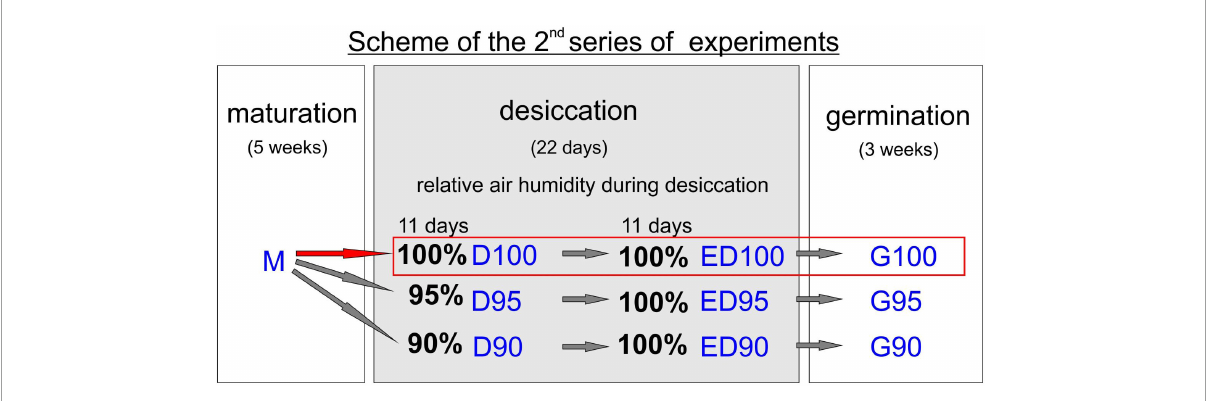
FIGURE1 Design of the second series of experiments and sampling. Mature somatic embryos (5 weeks of maturation, M) were subjected to three different systems of desiccation. Control embryos (in red) were exposed to 100% relative humidity throughout the process (sampling D100 and ED100). The second and third groups of embryos were subjected to 95 and 90% relative humidity, respectively, during the first half of desiccation (sampling D95 and D90) and then transferred to 100% relative humidity (sampling ED95 and ED90). The germination rate and morphology of embryos desiccated at different relative humidity levels were examined (G100, G95, and G90). The designation of all samples according to this scheme is used in the following text.